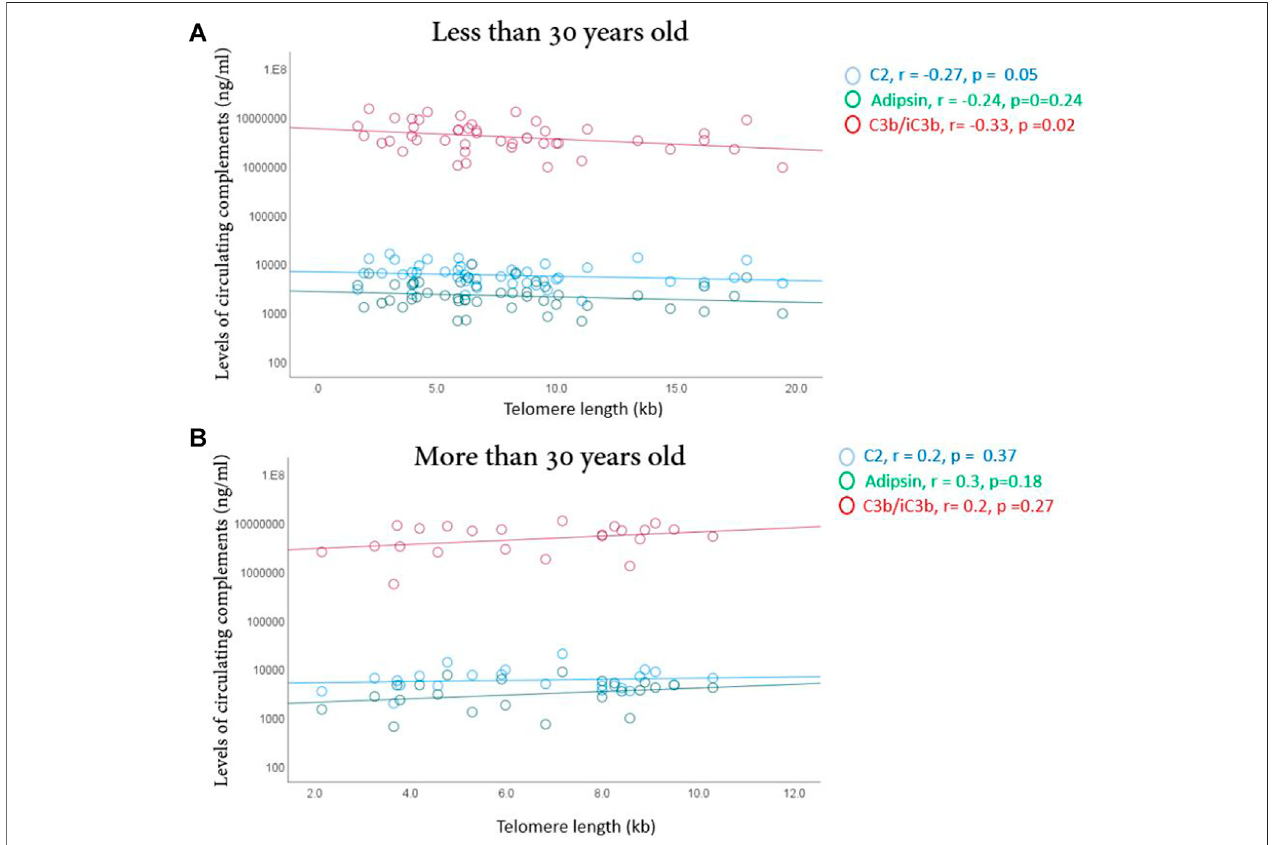
FIGURE 4 | Correlation between telomere length and the complements (C2, adipsin and C3b/iC3B) in younger (A) and older (B) elite athletes. Correlations were made using spearman ’ s correlation analysis. Correlation coef fi cient (r) and signi fi cance are